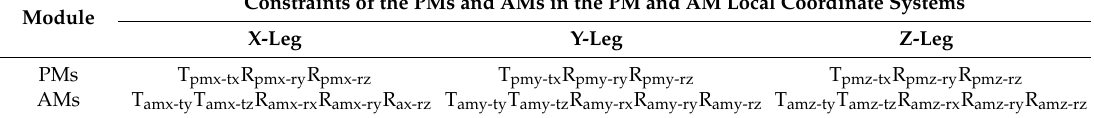
Table 2. Constraints of the passive modules (PMs) and active modules (AMs) in the PM and AM local coordinate